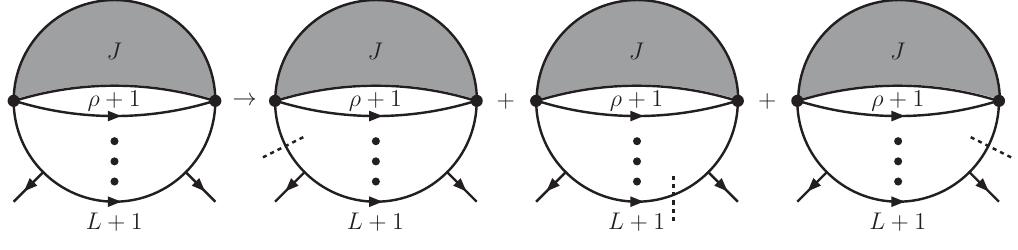
Figure 10 . Arbitrary topological complexity with external